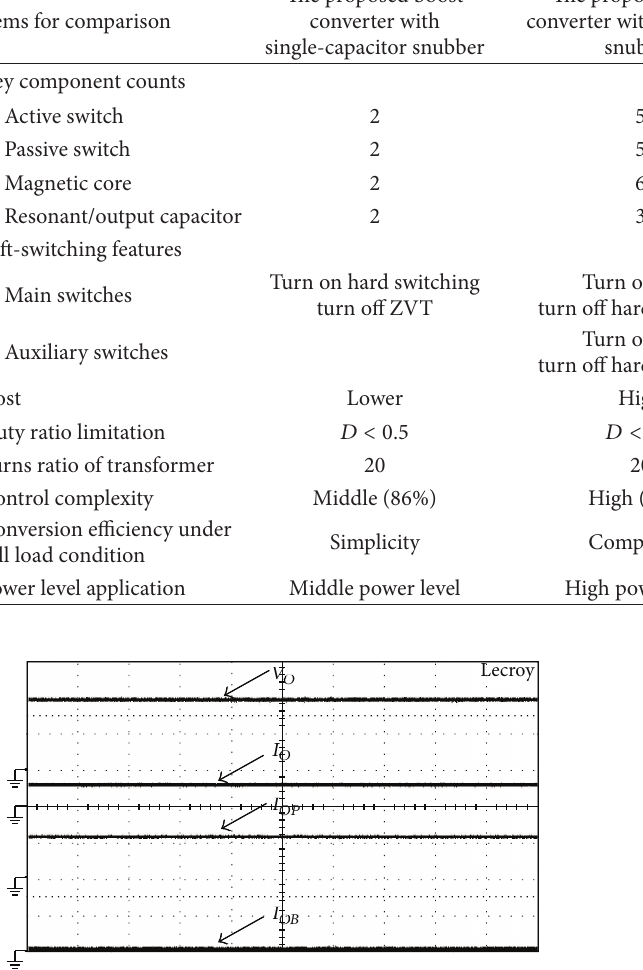
Figure 17: Measured voltage 𝑉 𝑂 , current 𝐼 𝑂𝐵 , 𝐼 𝑂𝑃 , and 𝐼 𝑂 waveforms of the proposed PV power conversion system using the single- capacitor snubber operated in mode VIII under ( 𝑃 𝑃( max ) +𝑃 𝐵( max ) ) ≥ 𝑃 ≥ 𝑃 𝑃 𝐿 and 𝐿 . PV ( max )